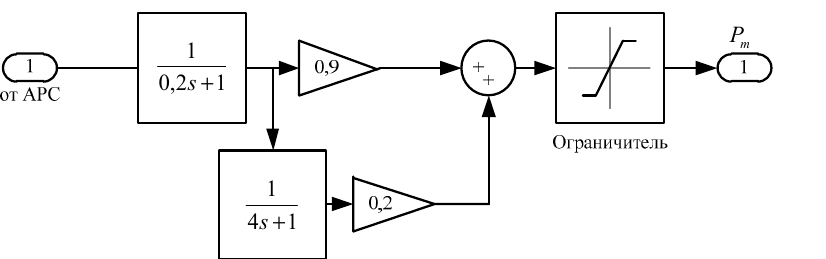
Figure 7. Structural diagram of the steam turbine model with intermediate steam extraction .